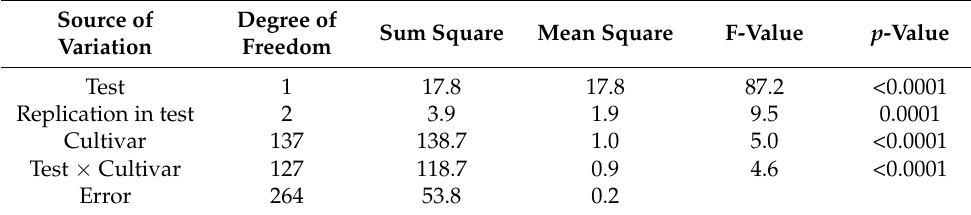
Table 1. Analysis of variance for reaction to bentazone on Korean soybean cultivars.